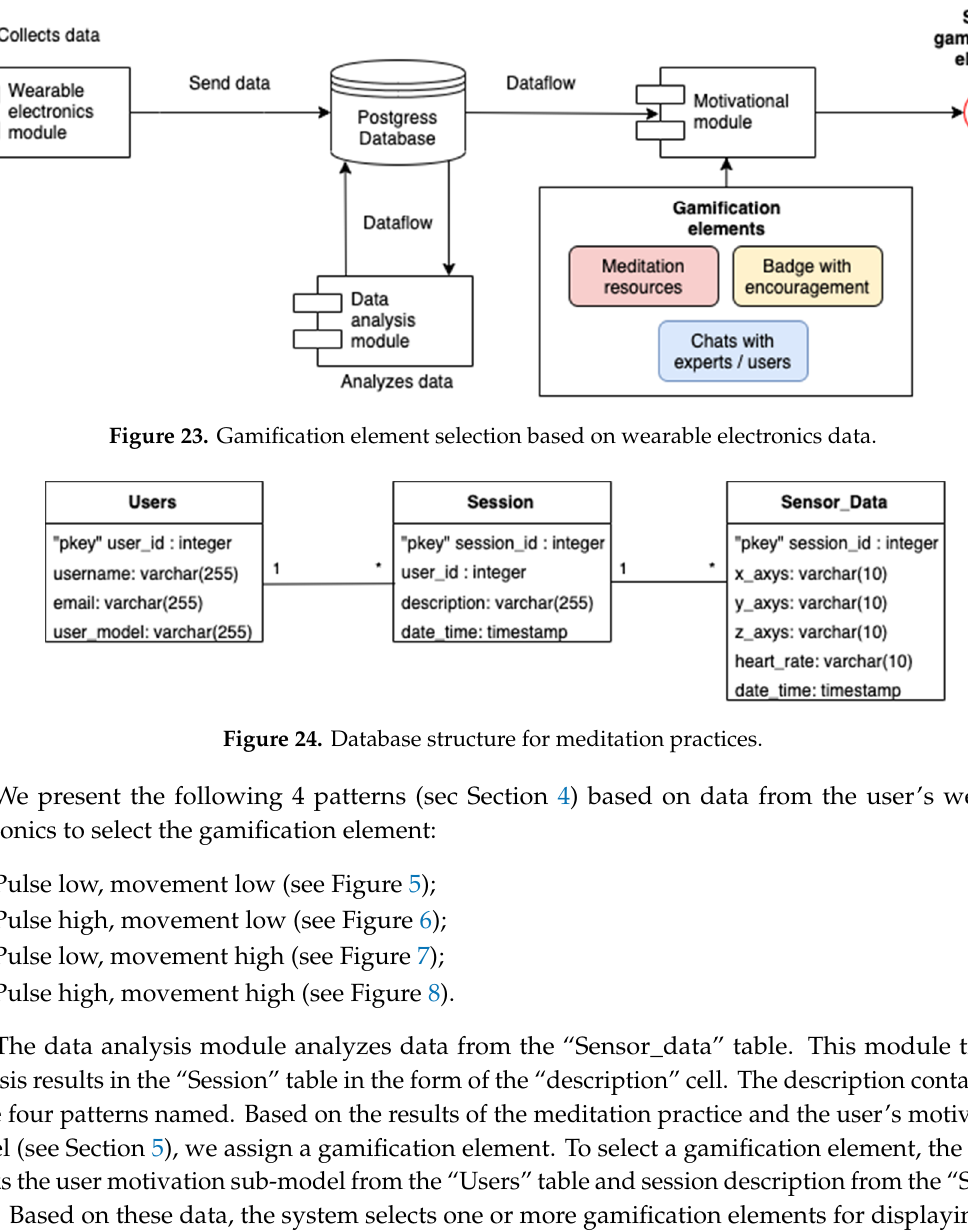
Figure 23. Gamification element selection based on wearable electronics data.